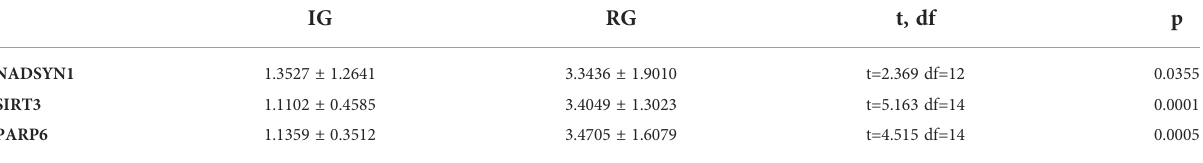
TABLE 2 Expression analysis between initial diagnosis and relapse samples. IG RG t, df